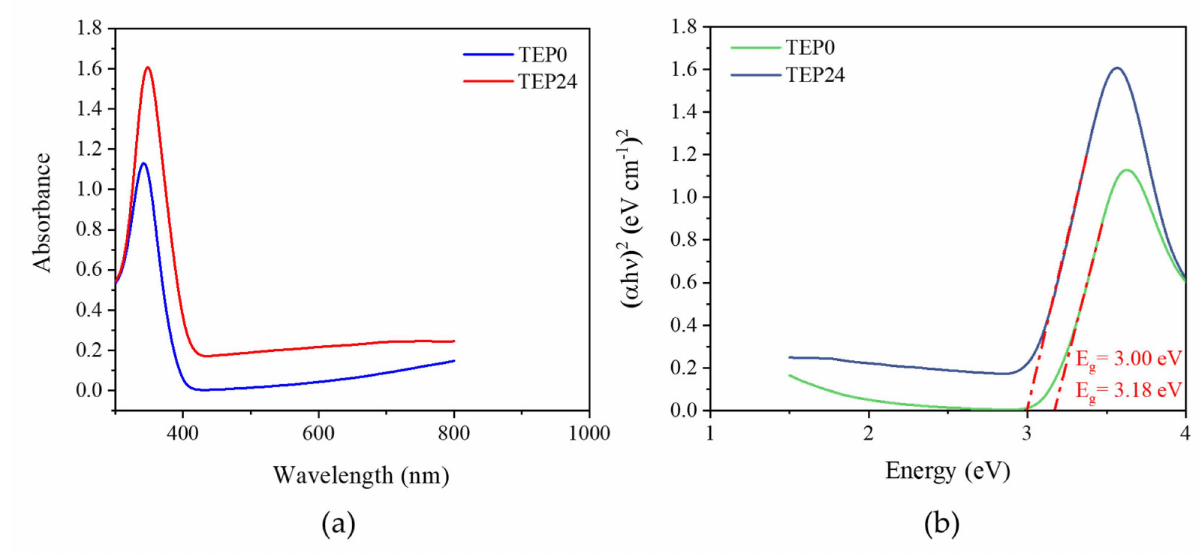
Figure 5. Calculated band structure of TiO 2 in ( a ) TEP0 and ( b ) TEP24 samples.